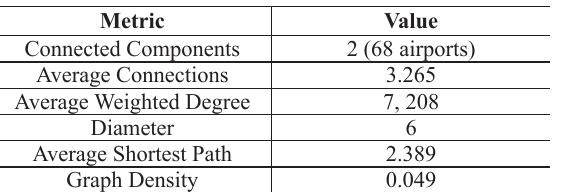
International Connections.